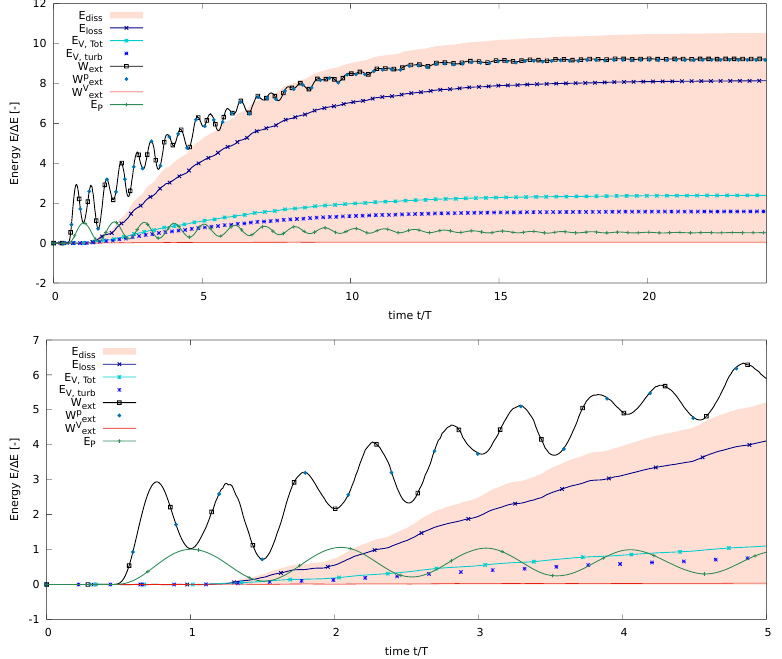
Figure 24. Water energy distribution for one of the N 200 runs.